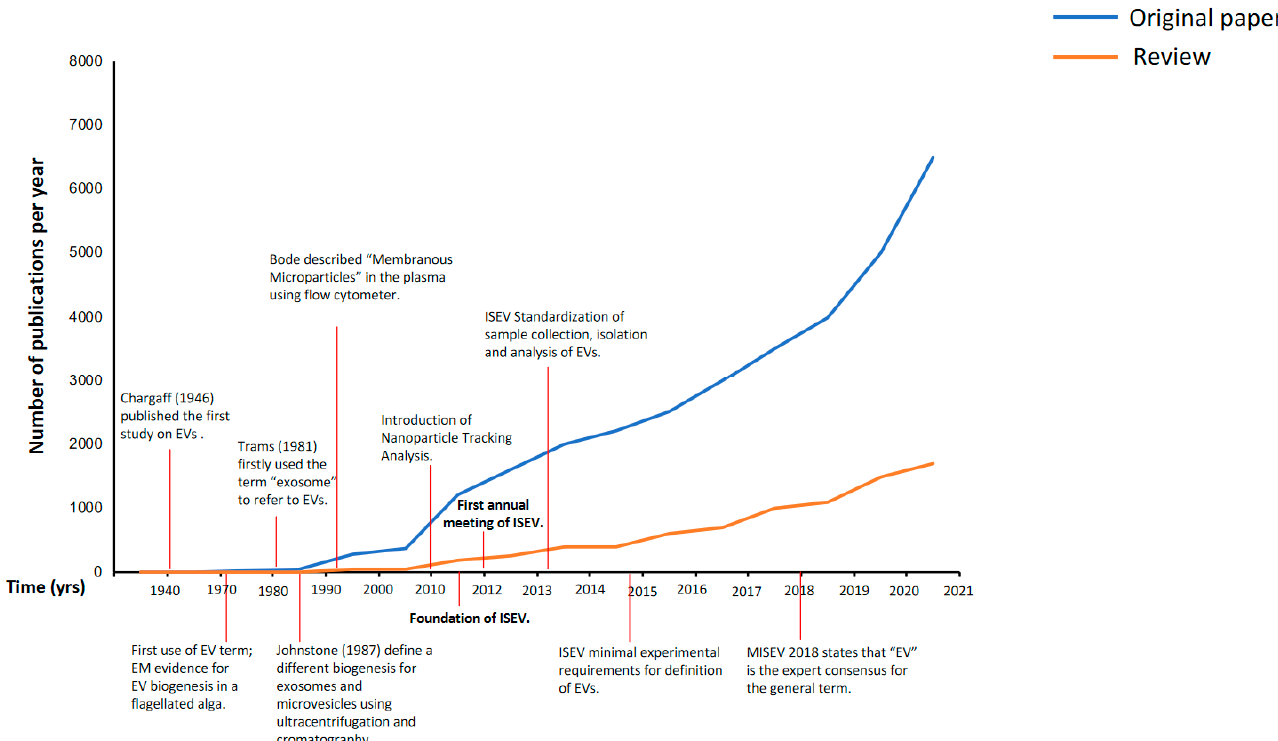
Figure 1. Number of publications per year in PubMed from 1946 to 2021. After the first annual meeting of the International Society of Extracellular Vesicles (ISEV) in 2012, the number of original papers and reviews including any extracellular- vesicle-related terms (exosomes, microvesicles, microparticles, and extracellular vesicles) increased exponentially. EVs: extracellular vesicles; EM: electron microscopy; ISEV: International Society of Extracellular Vesicles; MISEV: Minimal Information for Studies of Extracellular